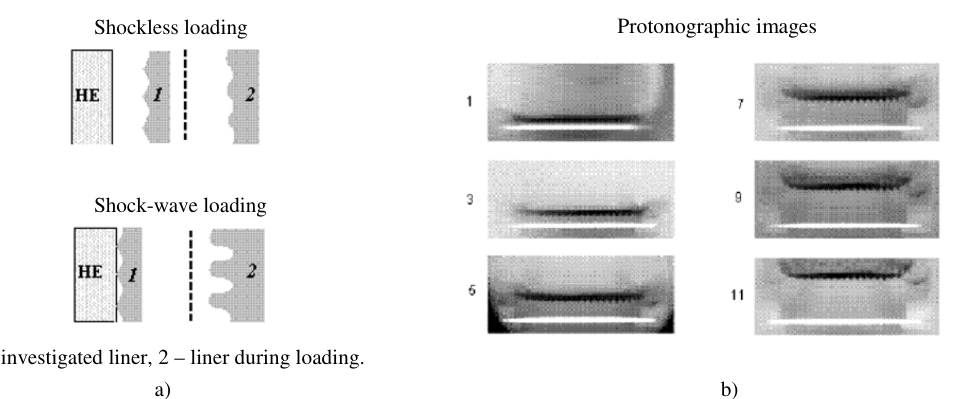
Fig. 1. Method for radiographic recording of perturbation growth: a – loading method; b, – examples of